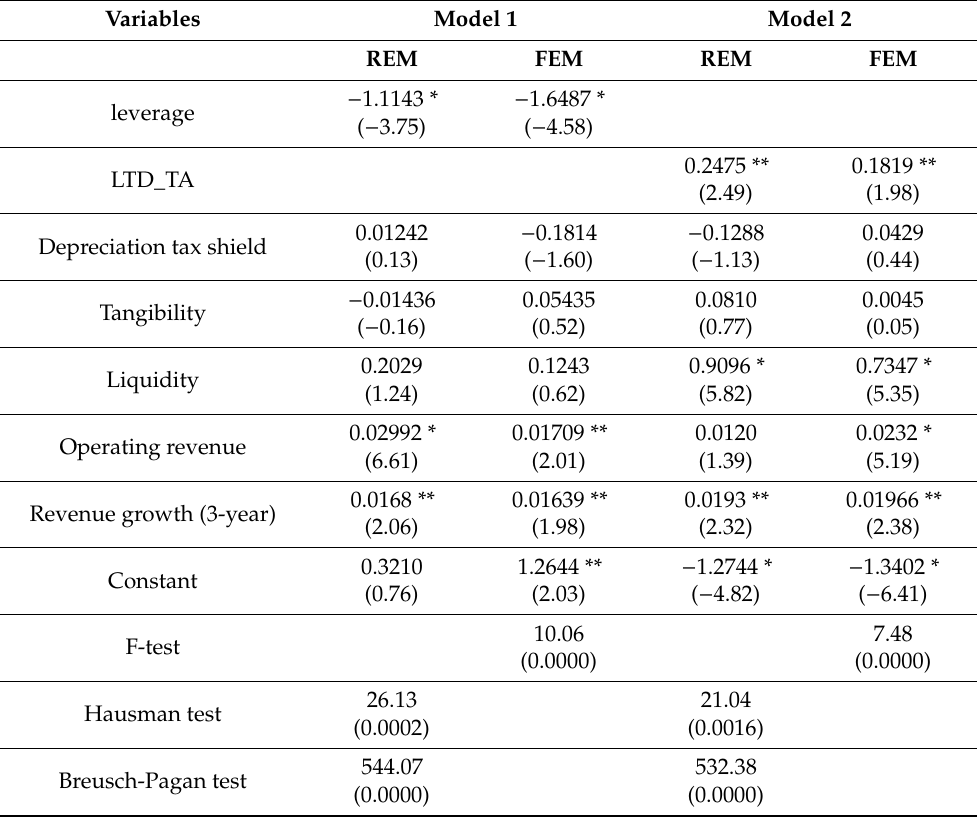
Table 5. Panel regression outputs for Return on Asset